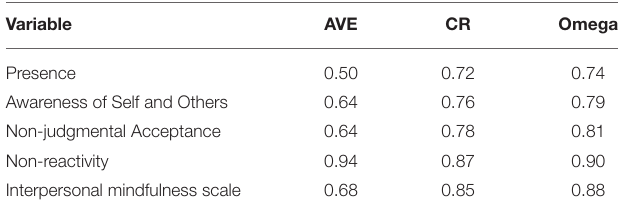
Moderation Test of Fields of Study In order to compare between three different fields of study (medical, technical and social science) in the proposed model, multi-group analysis was performed. The findings revealed